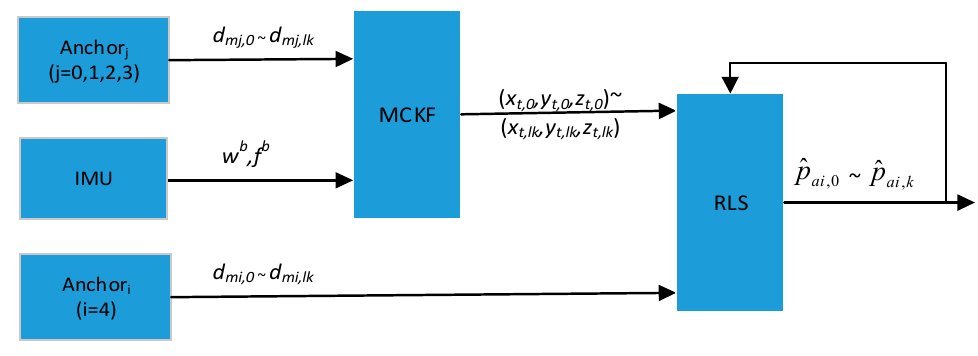
Figure 4. The architecture of the extension system.